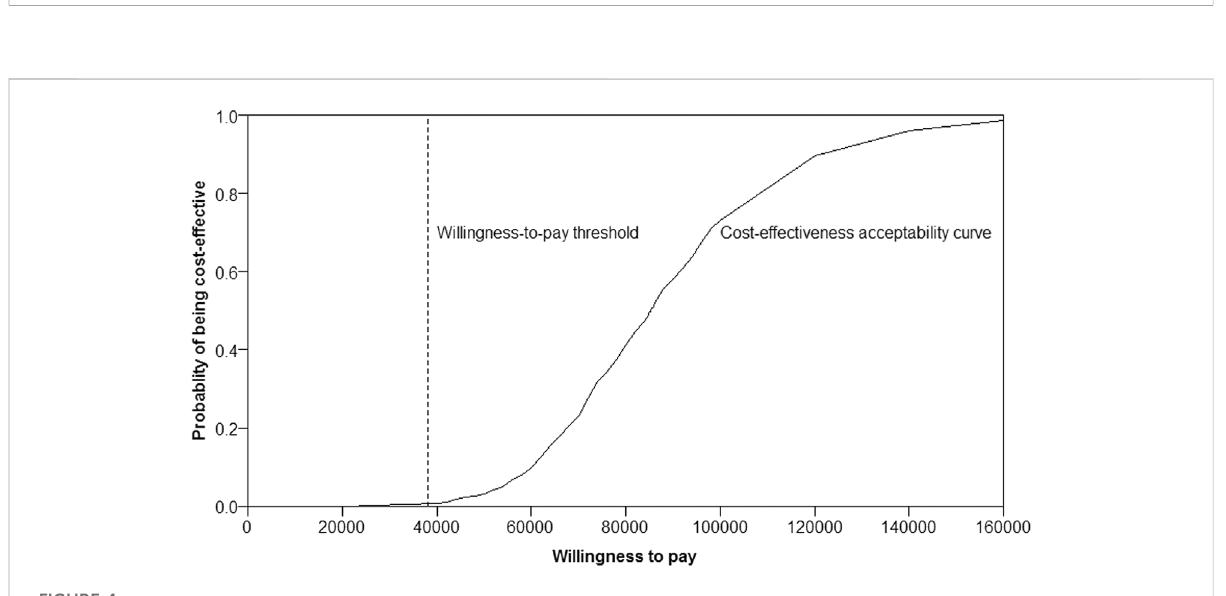
FIGURE 4 Acceptability curve of radium-223 being cost